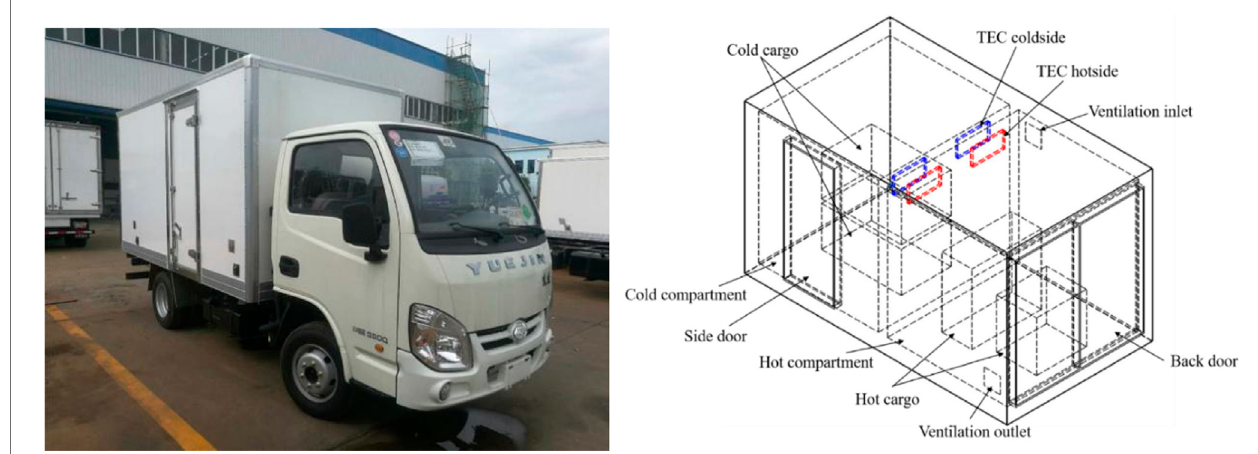
FIGURE 1 | Insulated van and Dual temperature zone insulated compartment model.